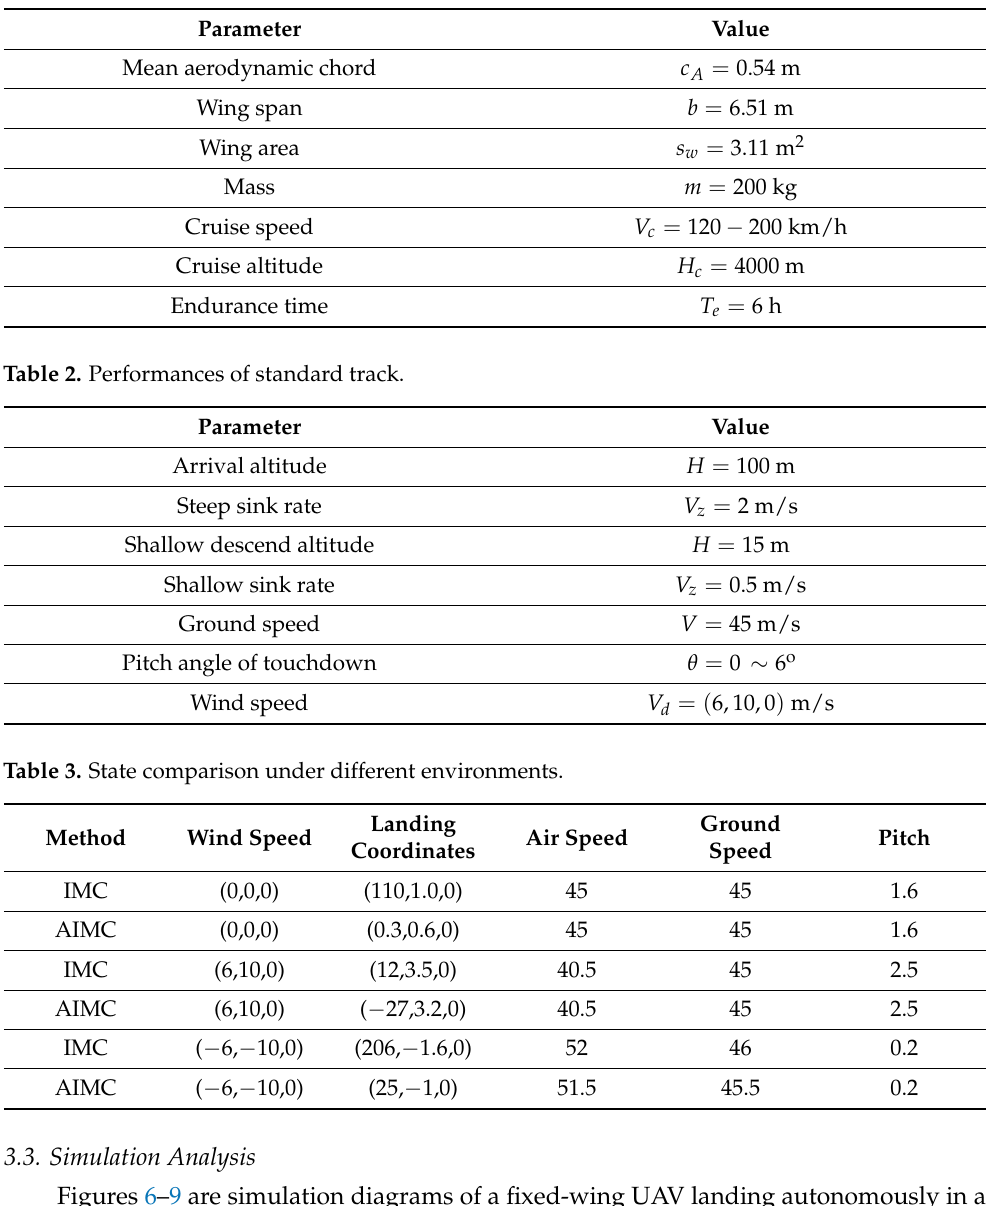
Table 1. Nominal parameters in fixed-wing UAV.